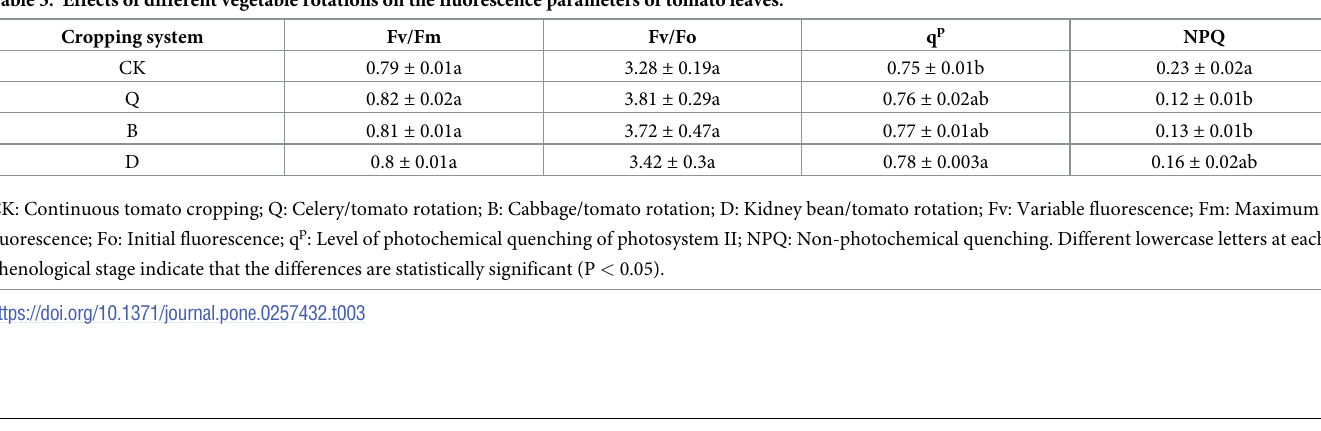
Table 3. Effects of different vegetable rotations on the fluorescence parameters of tomato leaves. Cropping system